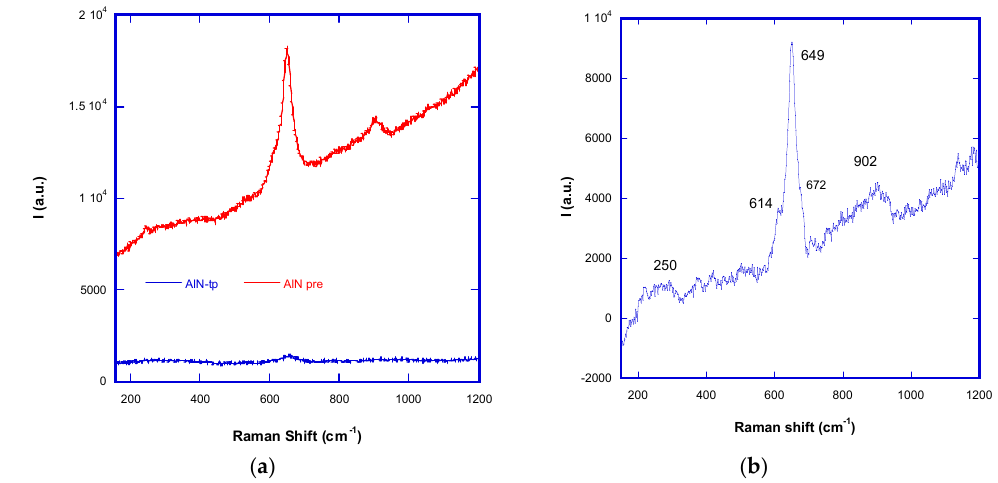
Figure 2. Micro-Raman analysis of thin AlN films deposited in two different regimens. ( a ) Comparison of Raman activity. ( b ) AlN pre thin-film vibrational analysis.